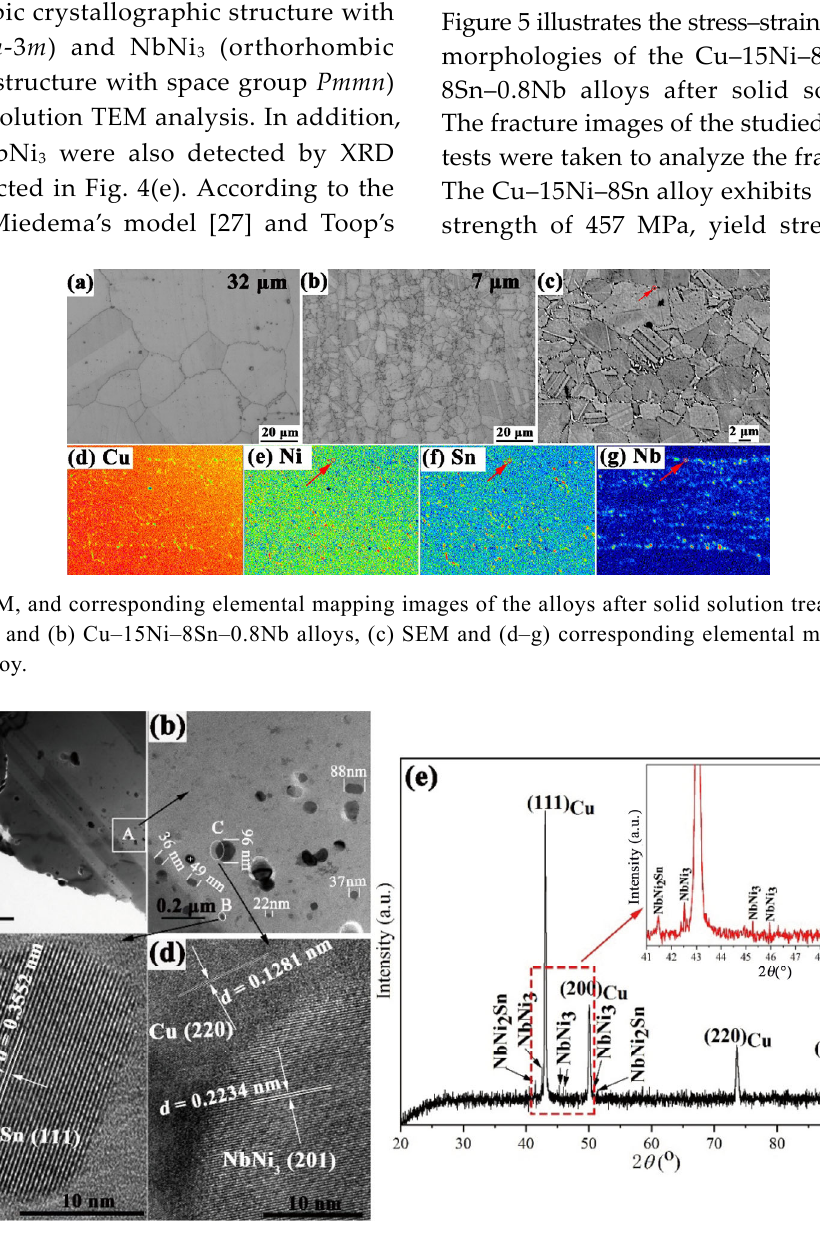
Fig. 4 TEM images and XRD patterns of the Cu–15Ni–8Sn–0.8Nb alloy after solid solution treatment: (a, b) bright-field TEM, (c, d) high-resolution TEM, and (e) XRD. d is the diameter of